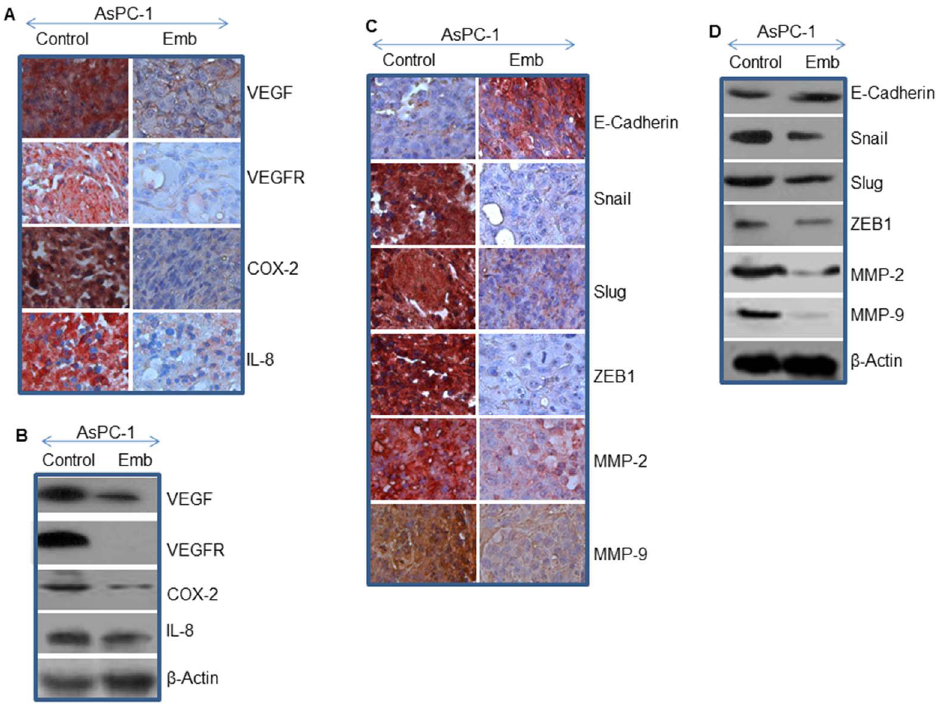
Figure 6. Effects of embelin on markers of angiogenesis, and epithelial-mesenchymal transition. (A), Immunohistochemistry was performed to examine the expression of VEGF, VEGFR, Cox-2, and IL-8 in tumor tissues isolated from control and embelin-treated mice. (B), Western blot analysis was performed to measure the expression of VEGF, VEGFR, Cox-2, and IL-8. The b -actin was used as a loading control. (C), Immunohistochemistry was performed to examine the expression of E-cadherin, Snail, Slug, ZEB1, MMP-2 and MMP-9 in tumor tissues isolated from control and embelin-treated mice. (D), Western blot analysis was performed to measure the expression of E-cadherin, Snail, Slug, ZEB1, MMP-2 and MMP-9. The b -actin was used as a loading control.